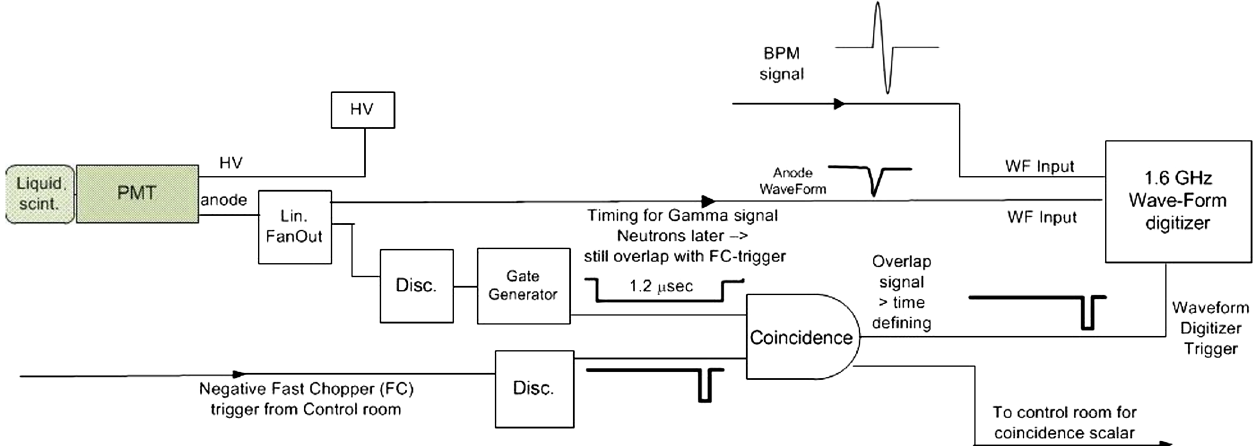
FIG. 10. Fast timing diagram for TOF via waveform measurements of the liquid scintillator detector and the BPM with the fast chopper (FC) serving as a trigger for the waveform digitizer.